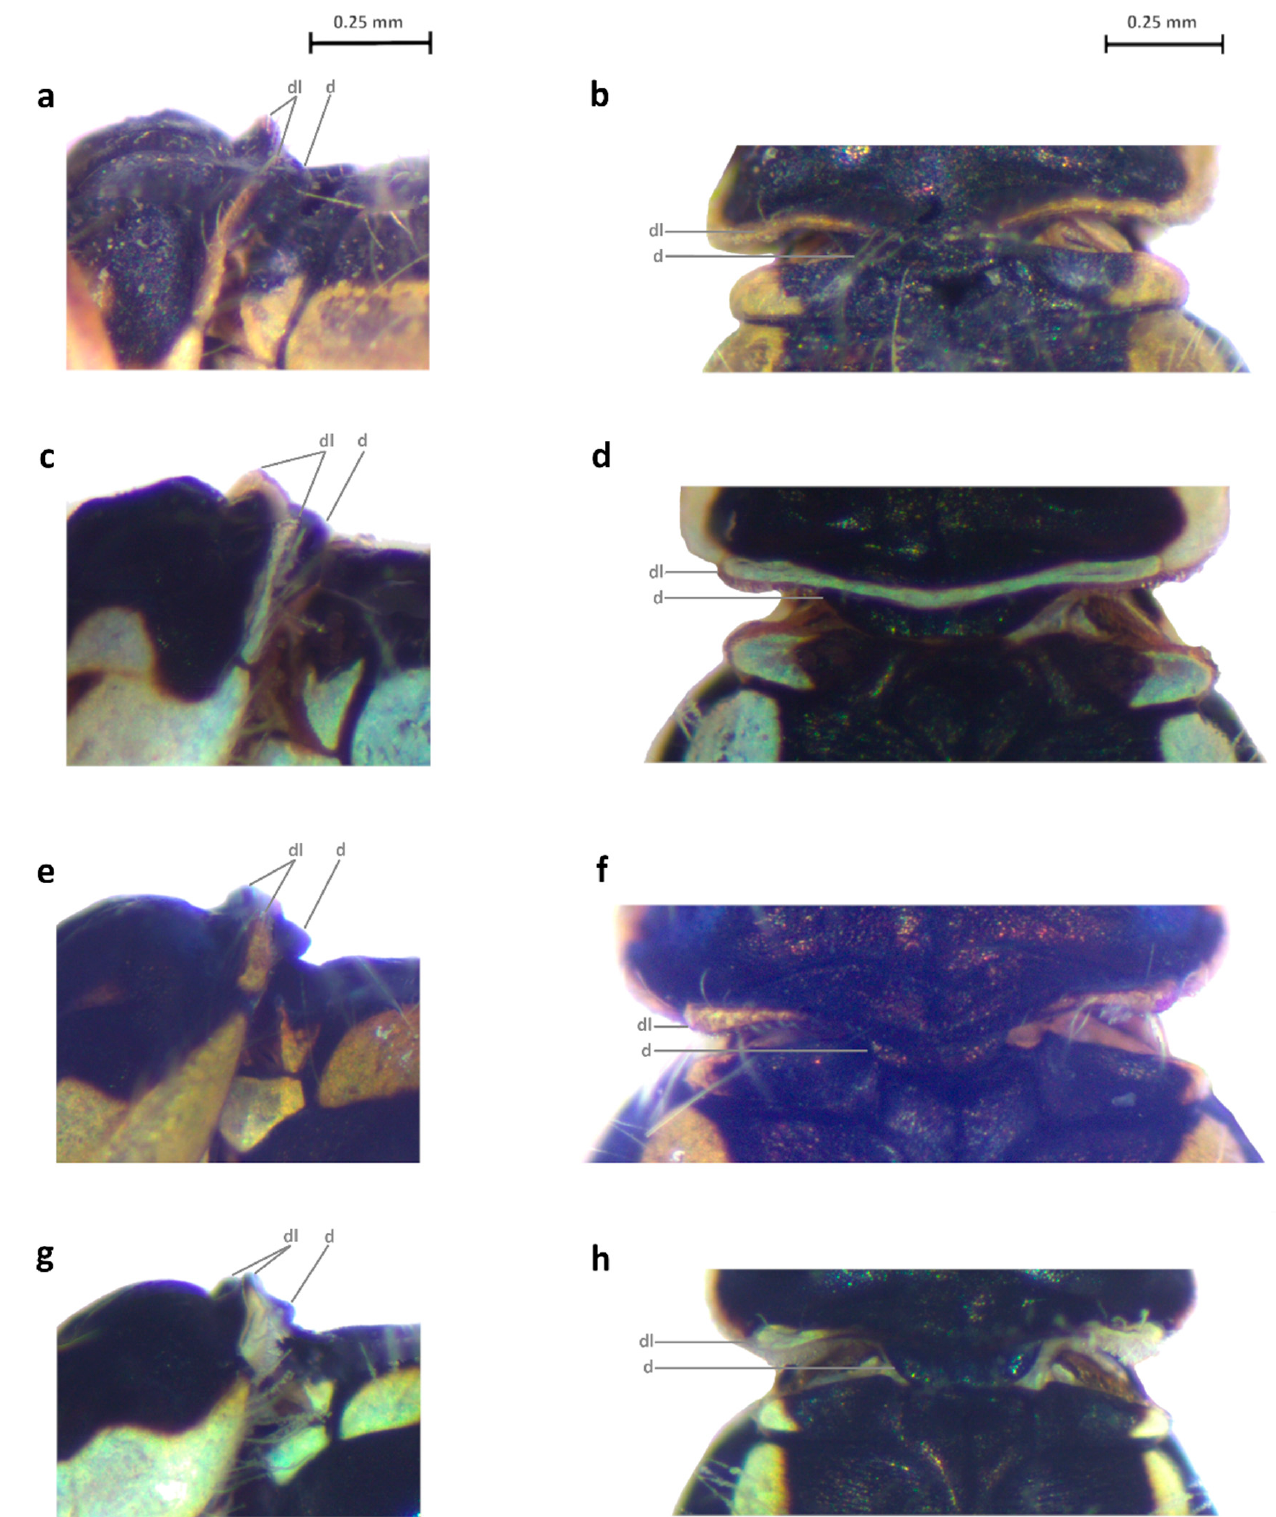
Figure 6. Posterior part of the pronotum and the anterior part of the mesothorax in females of Ischnura rubilio (lateral: ( a ), dorsal: ( b )) and Ischnura aurora from China (lateral: ( c ), dorsal: ( d )), Australia (lateral: ( e ), dorsal: ( f )), and Fiji (lateral: ( g ), dorsal: ( h )). dl : dorso-lateral elevation. d : dorsal expansion. Note that no mesostigmal protuberances exist in females. Legs: No differences in leg colouration were found between the examined specimens. Wings: Cell number was variable within and between all the studied populations. Abdomen: Ischnura rubilio and I. aurora males from China show a less expanded black colouration on the dorsal part of S2 than that observed in I. aurora from China and Fiji . In the former, the apical stripe on S2 expands into a mid-dorsal stripe that reaches to approximately half of the segment, whereas in the I. aurora specimens from Australia and Fiji, this mid-dorsal stripe is much wider and may reach up to the end of S2 in some individuals (Figure 7). The basal articulation of S2 appears to be circled in black in the I.